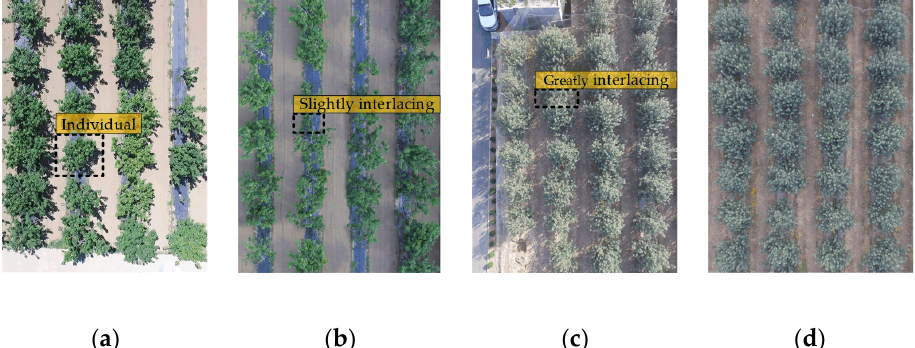
Figure 1. The illustrations of images under different lighting conditions and interlacing situations: ( a ) cherry trees, sunny day; ( b ) cherry trees, cloudy day; ( c ) apple trees, sunny day; ( d ) apple trees, cloudy day.